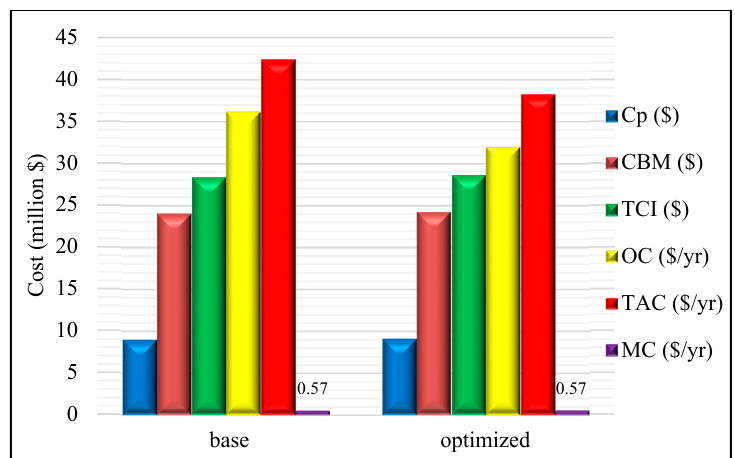
Figure 13. Economic analysis of N 2 dual expander process LNG process.